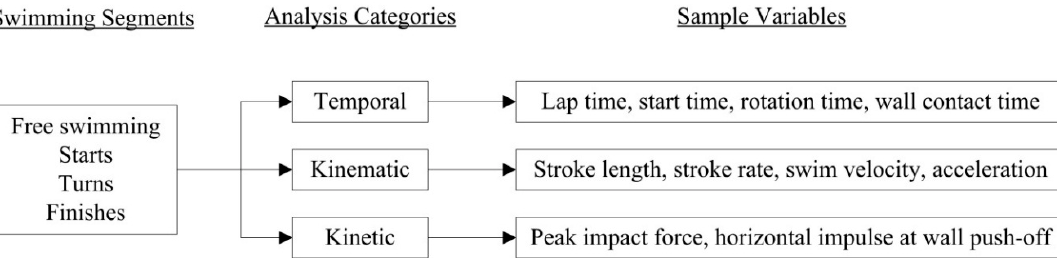
Figure 2. Swimming can be broken down into different segments to facilitate technical analysis and different categories of performance related variables can be selected for measurement.